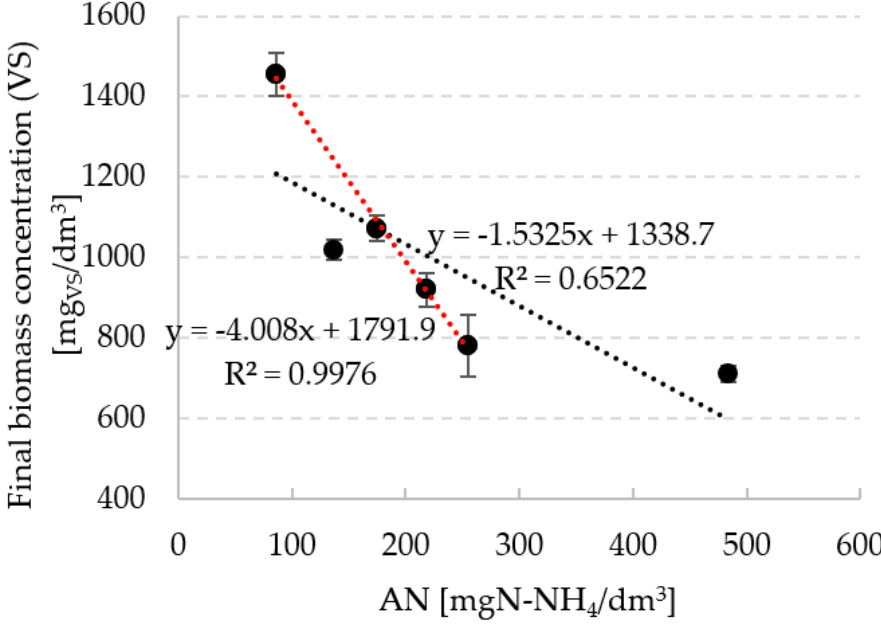
Figure 4. Correlation between initial ammonia nitrogen (AN) concentration and final production of microalgae biomass.